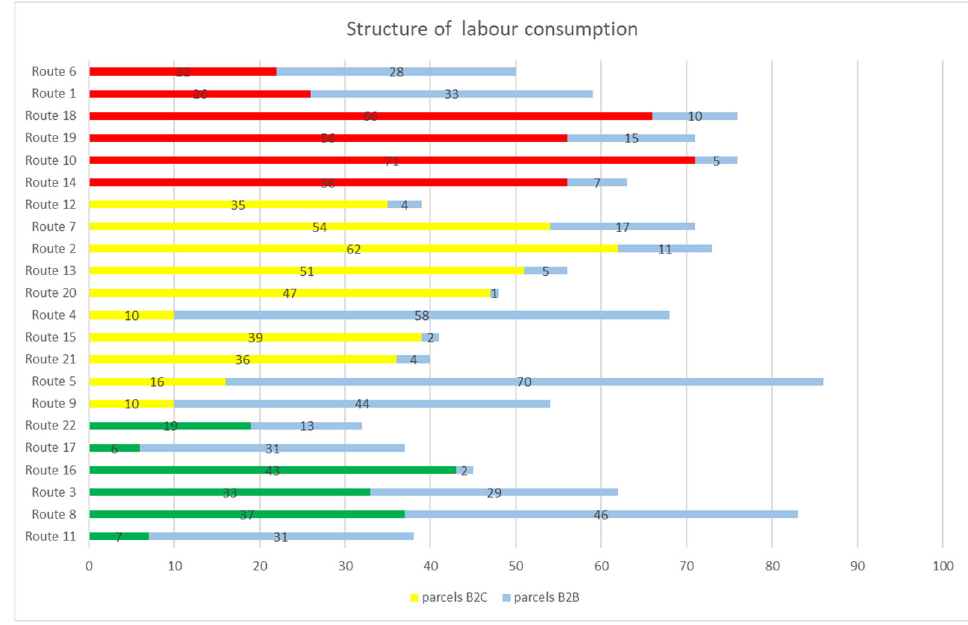
Figure 9. The structure of labor consumption of deliveries by B2B vs. B2C on the particular route. Colors represents: green—group A, yellow—group B, red—group C. Source: Own study.